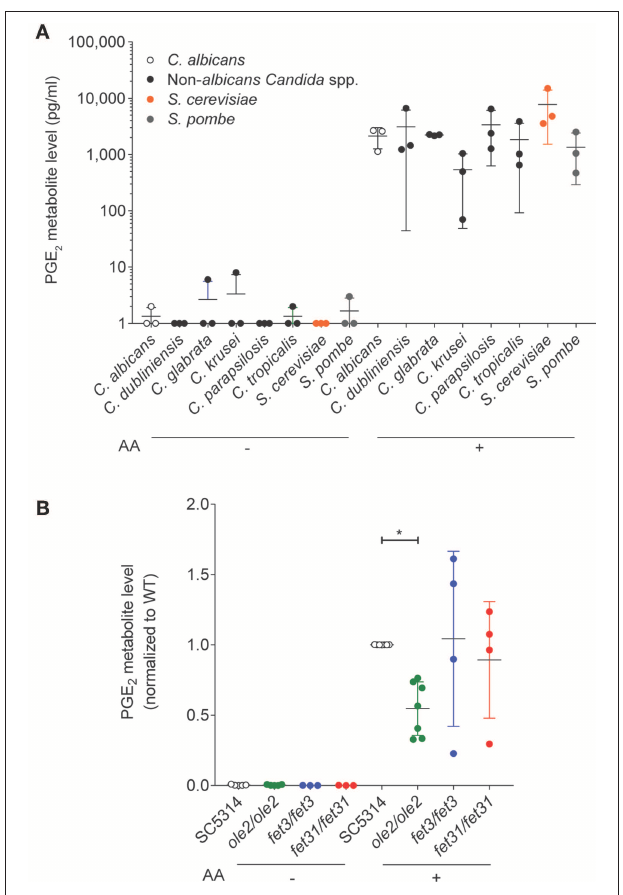
FIGURE 1 | In vitro PGE 2 production by various C. albicans strains. Levels of PGE 2 metabolite, a stable derivative of PGE 2 , in the supernatants of in vitro cultures of various fungal species (A) or C. albicans strains (B) , were assayed by ELISA. Arachidonic acid (AA) was added ( + ) or not (–) to the cultures. Data pooled from 3 to 7 independent experiments. Mean ± s.d. * p < 0.05; One-way ANOVA with Dunnett’s multiple comparisons